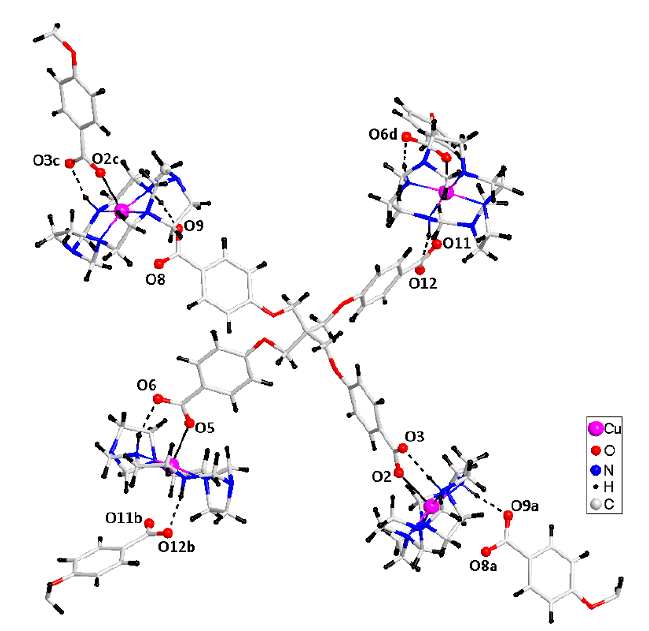
Figure 3. View of the interactions through hydrogen bondings between a TCM 4- tetraanion and four different complex cations [Cu(CHA)] 2+ in the crystal of 3 •11H